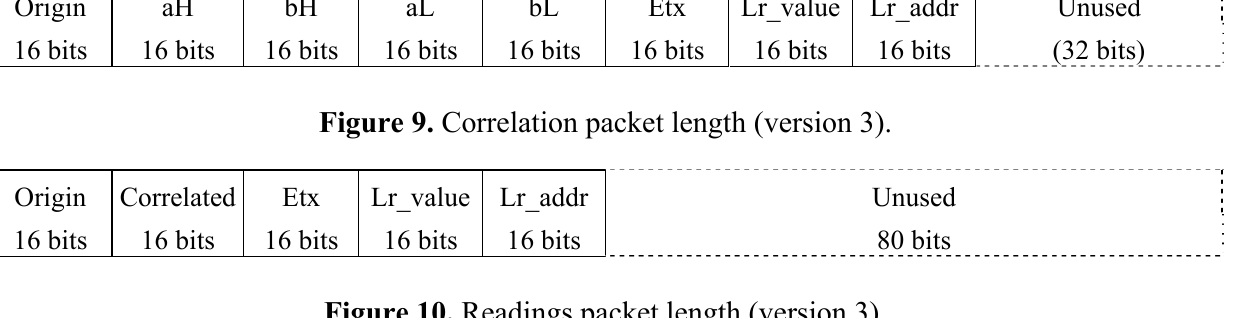
Figure 10. Readings packet length (version